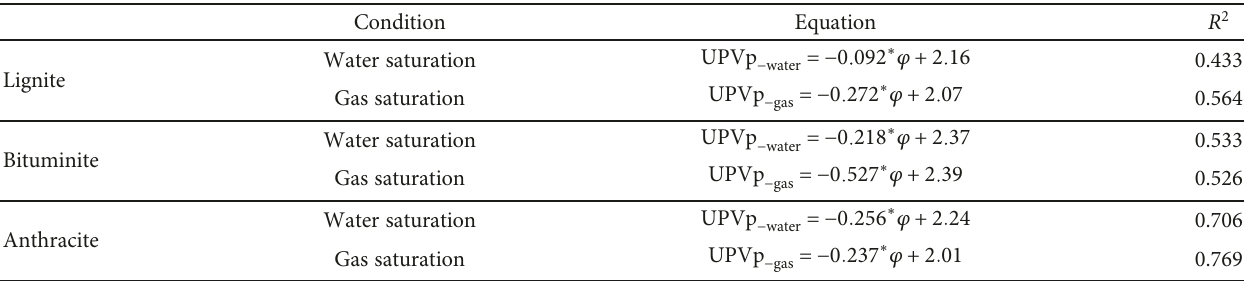
Figure 7: Scatterplot and linear correlations between UPVp and porosity under water and gas saturation for (a) lignite, (b) bituminite, and (c) anthracite (d) showing a sketch of wave transmission within the coal matrix. Table 6: Linear fi t equations between UPVp and porosity at water and gas